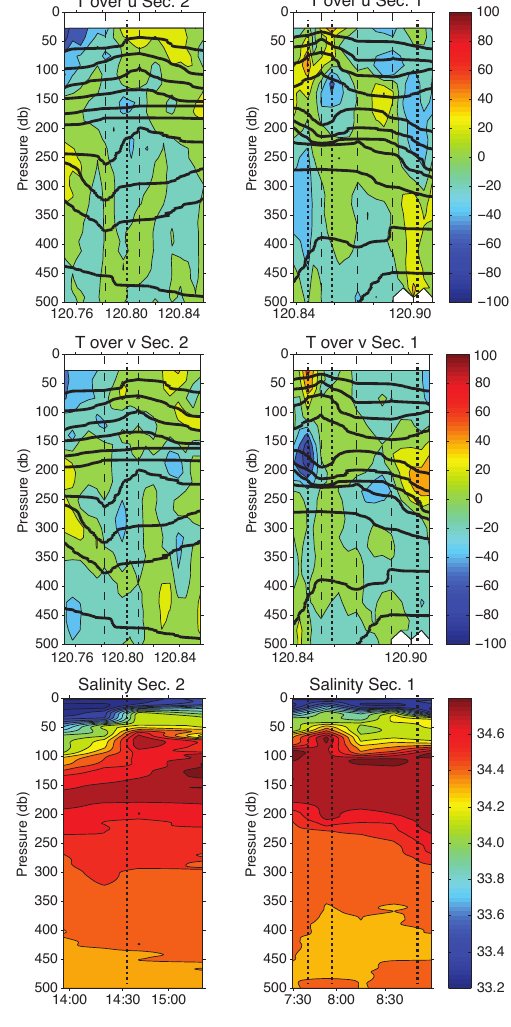
Figure 5. Temperature from the UCTD overlaid on the zonal (top) and meridional (middle) velocity from the ship’s hull-mounted ADCP. The mean velocity profile has been removed from both com- ponents. The right panels are from Sect. 1 and the left panels from Sect. 2 as shown in Fig. 1b. The corresponding salinity sections are on the bottom. The top two panels are plotted against longitude and the bottom against the corresponding time. Dashed vertical lines in- dicate the station positions, including two on the borders. Dotted vertical lines indicate the wave core positions/times as indicated by